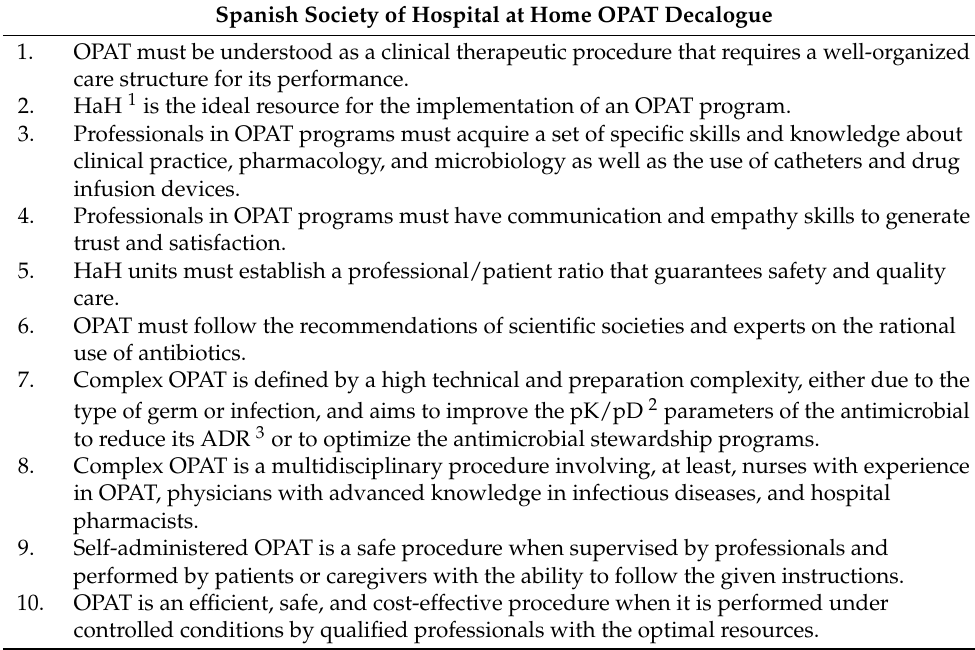
Table 1. Decalogue defining OPAT care model by SEHAD